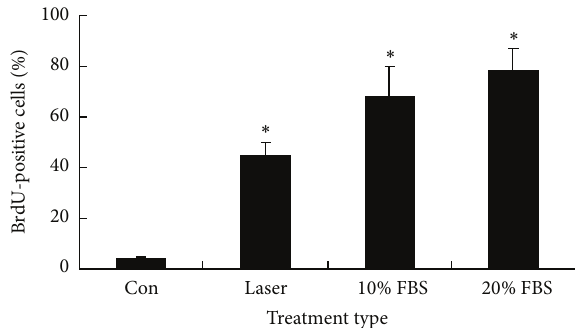
Figure5:CartogramofflowcytometricanalysisregardingthepercentageofBrdU-positivecellsasrepresentedbymeanfluorescenceintensity from the above groups, indicating that the number of cells in S phase was significantly increased after irradiation/refeeding treatment. ∗ Versus control, 𝑃 < 0.05 . Con stands for control.